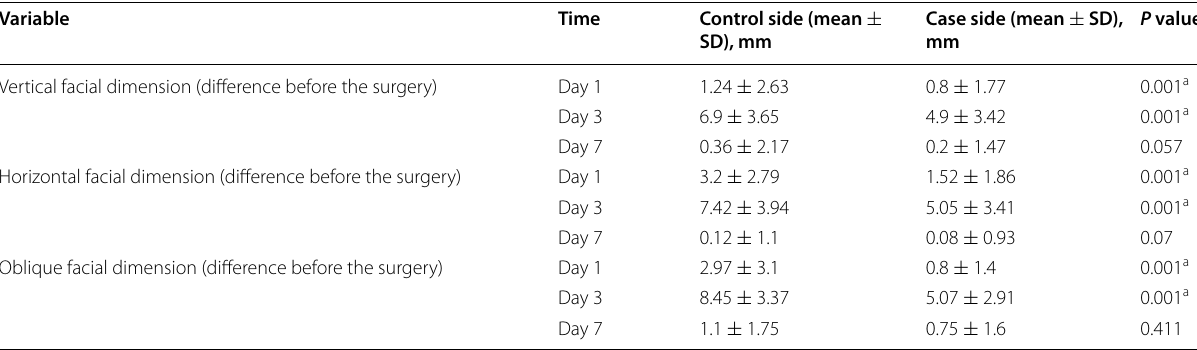
SD standard deviation a Statistically significant